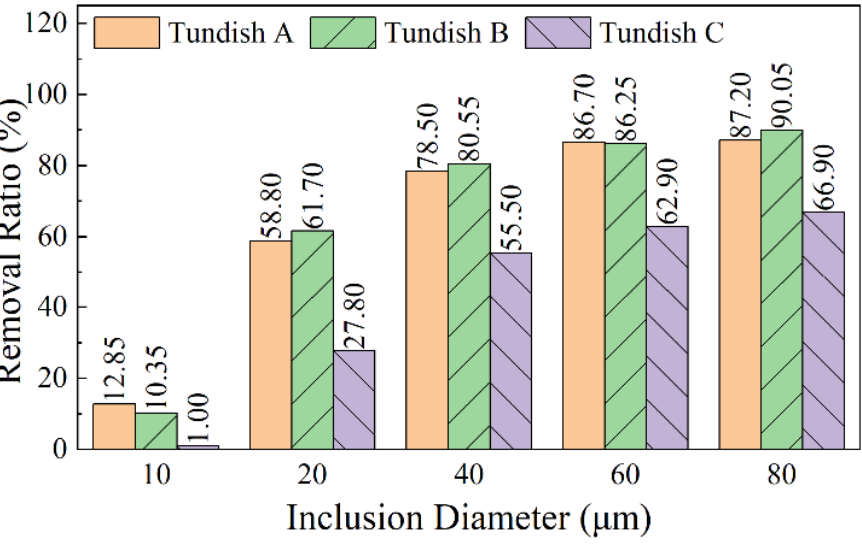
Figure 19. Removal ratios of inclusions in distributing chamber.